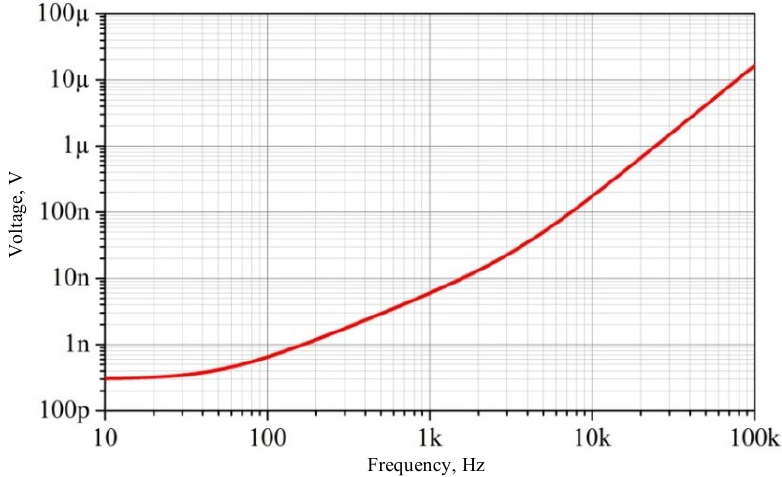
Figure 5. The PGA207 output voltage with the voltage follower output stage with embedded solar cells.